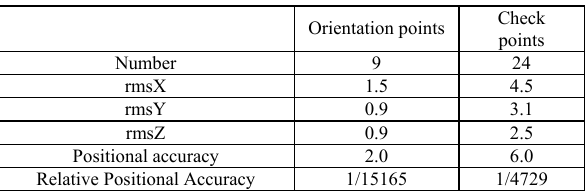
Table3. Precision of the west wall of fluted circumvallation (unit: mm, sigma naught value: 1.946 μ m)